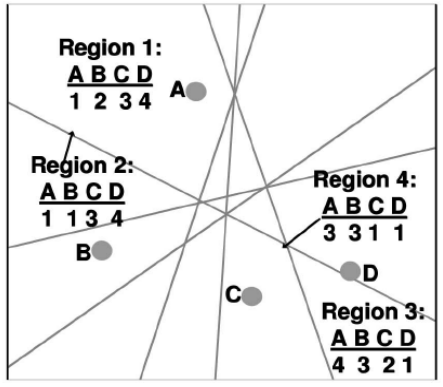
Figure 1. Example of rank sequences for four anchor